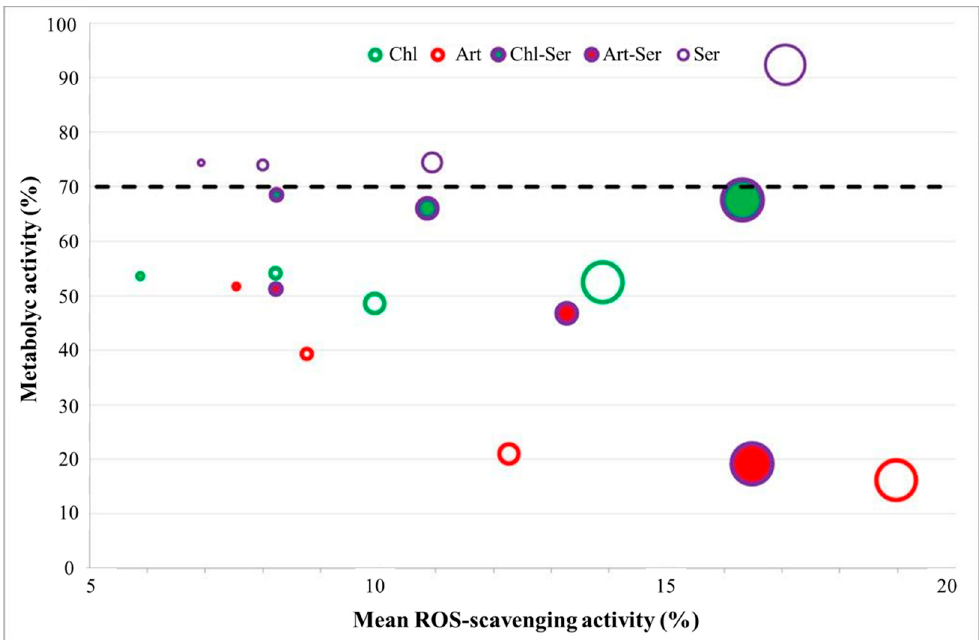
Figure 5. Mean ROS-scavenging activity (%) and cell metabolic activity % for the all tested formulations. The diameter of the circles in the plot is proportional to the microsphere concentration: the larger circles correspond to the 10 mg/mL, the intermediate and intermediate-small circles are those of the 5 and 2.5 mg/mL, while the smaller circles represent the properties of the 1.25 mg/mL concentration of microspheres.